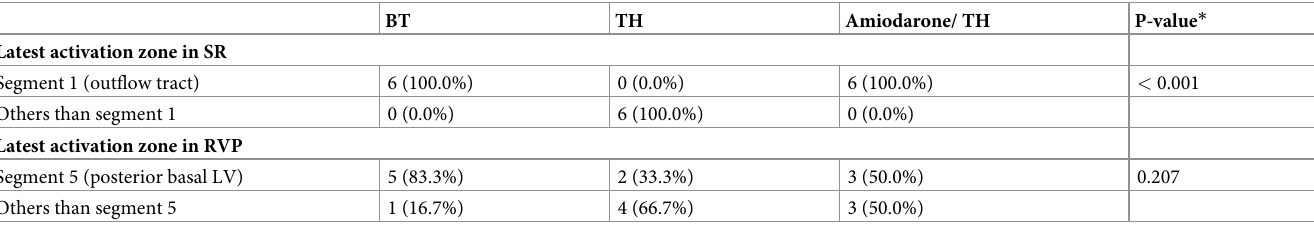
Table 4. The latest epicardial activation site after hypothermia or the treatment of amiodarone. BT TH Amiodarone/ TH P-value * Latest activation zone in SR 6